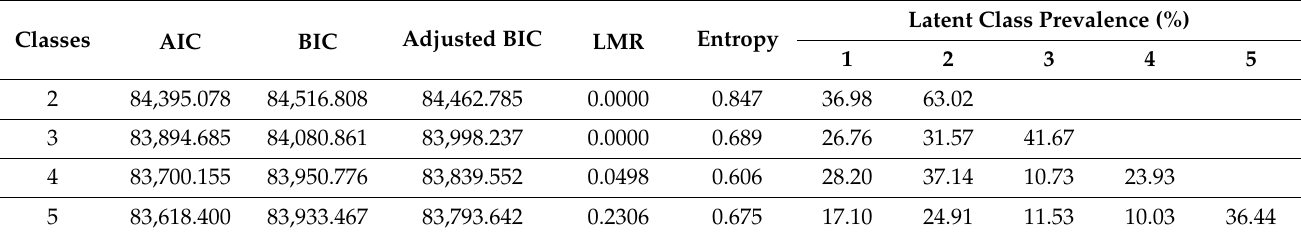
Table 1. Model fit statistics of the LCA models.